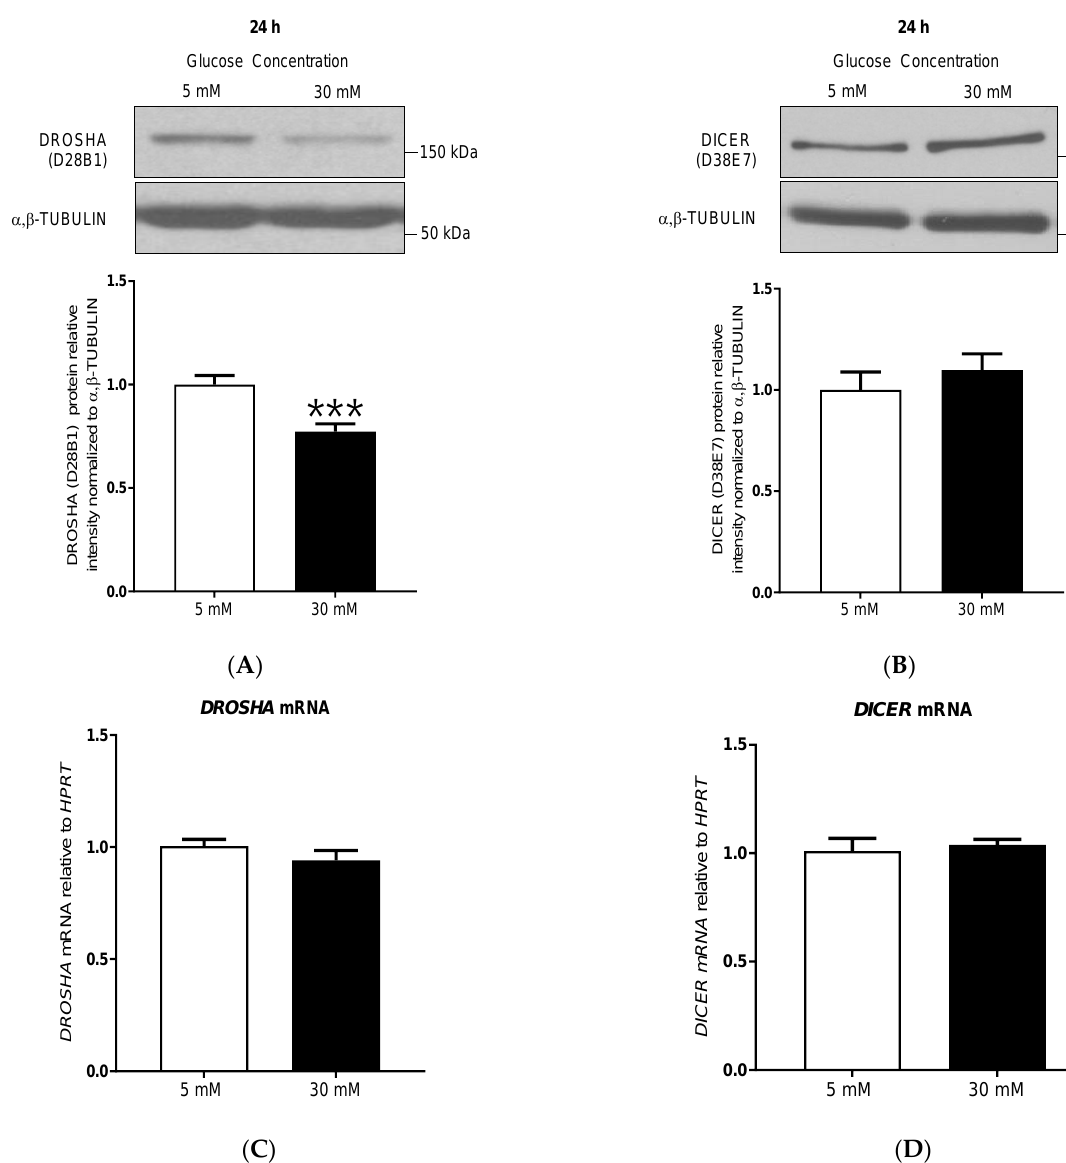
Figure 1. High glucose treatment decreases DROSHA protein expression in human primary dermal microvascular endothelial cells (HDMECs). ( A,B ) Representative immunoblots and densitometry analysis for ( A ) DROSHA (D28B1) and ( B ) DICER (D38E7) protein expression levels in primary human dermal microvascular endothelial cells (HDMEC) after 24 h treatment with low (5 mM) or high (30 mM) glucose concentrations. α/β-TUBULIN was used as a loading control. Data are means ± SEM. ( n = 12, t -test, *** p < 0.001 vs. 5 mM). ( C,D ) DROSHA and DICER1 mRNA expression relatively to HPRT in HDMEC treated with low (5 mM) or high (30 mM) glucose concentrations for 24 h. Data are means ± SEM. ( n = 8, DICER1 mRNA; n = 12, DROSHA mRNA).